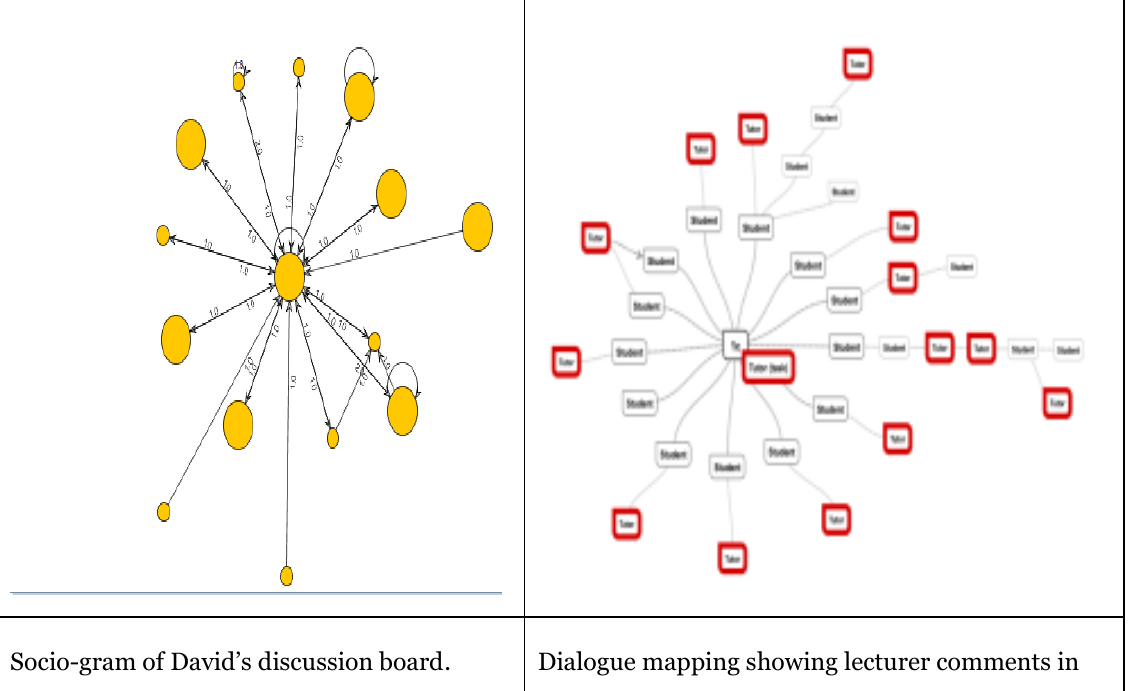
Figure 3. Visualisations of a discussion board: